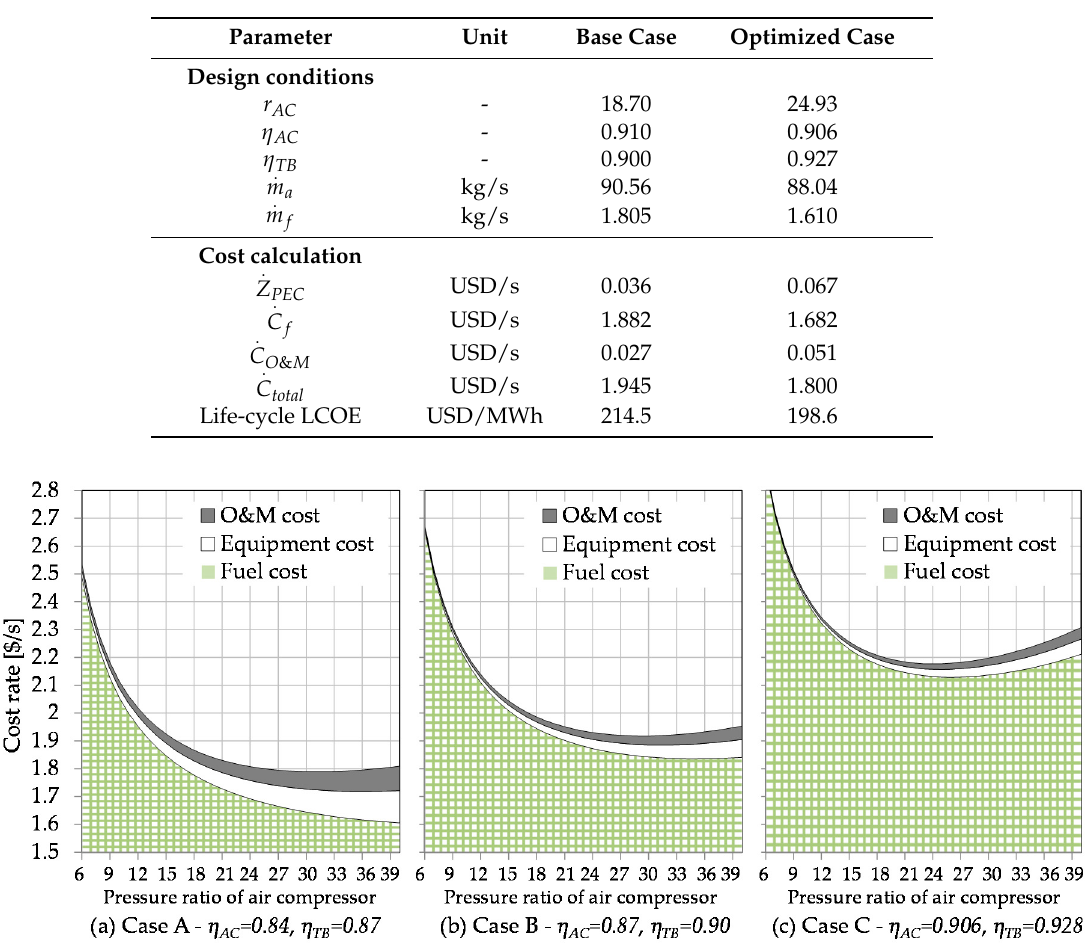
Table 8. Optimized results and relevant cost calculations for gas turbine simple cycle. LCOE—levelized cost of electricity.